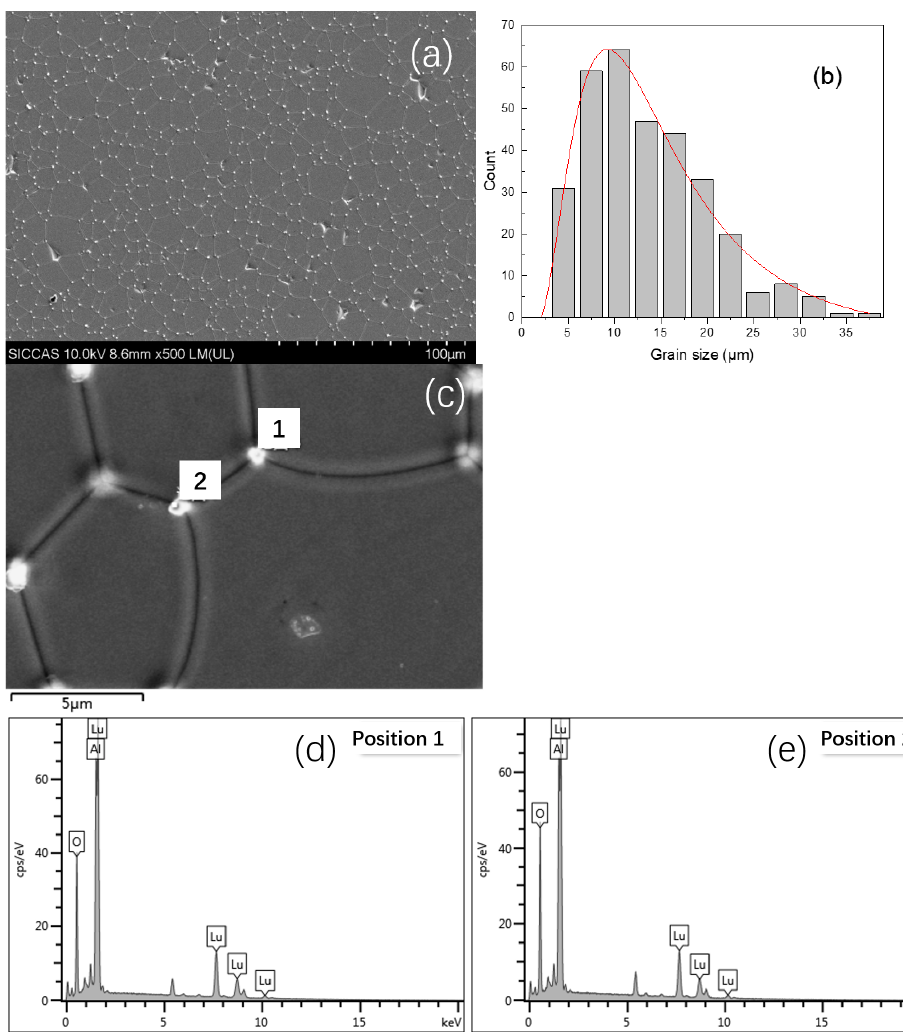
Figure 4. ( a ) SEM graph of Ce, Pr:LuAG ceramic after thermal etched at 1500 °C for 3 h in air with a slightly flowing O 2 ; ( b ) grain size distribution; ( c – e ) element analysis of position 1 and position 2 of the triple grain boundary junctions by EDS, respectively.